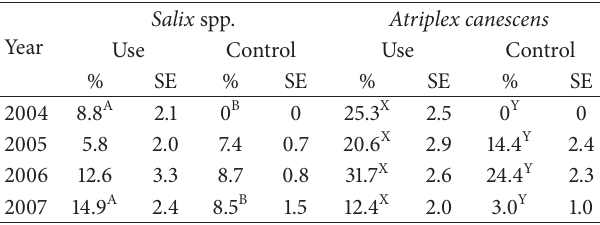
Table 3: Mean percent cover of plants, cryptogamic crust, bare soil, and rock in use (Chacra Mesa, Chacra Fingers) and control (South/West Mesas) areas, Chaco Culture National Historical Park, August-September 2004 and 2006. Plant Crust Bare soil Area